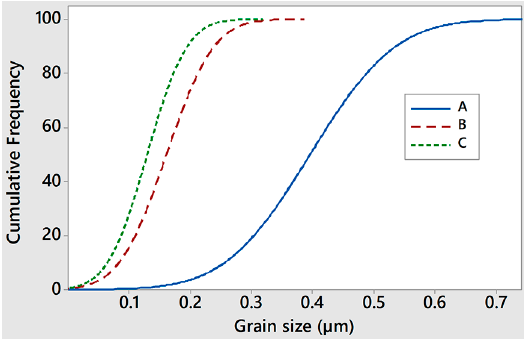
Figure 5. Grain size distribution for each composition sintered at1350°C